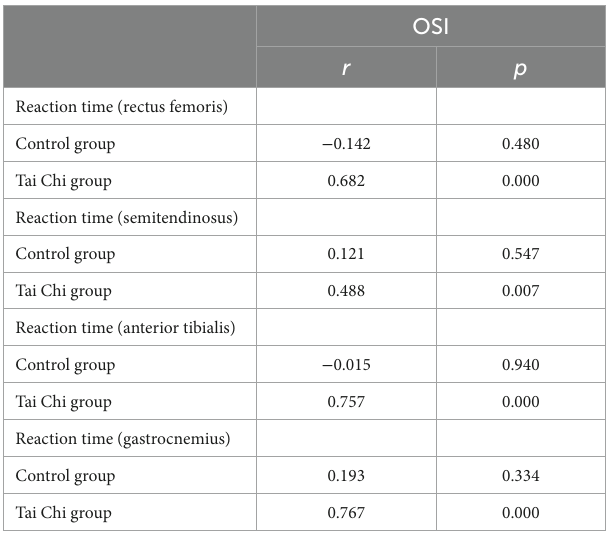
TABLE 4 Correlations of changes in reaction time with changes in OSI among Tai Chi Group ( n = 27) and control group ( n =